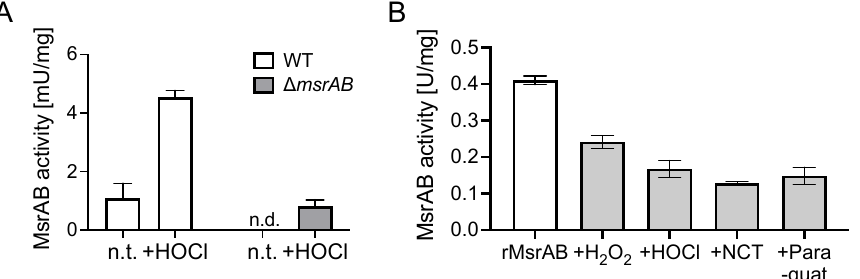
Figure 3. Effects of oxidative stress agents on rMsrAB activity. ( A ): MsrAB activity in Hi2019 wildtype and msrAB strains during microaerobic growth with or without exposure to hypochlorite. ( B ): Effect of exposure to ROS or RCS on activity of purified rMsrAB. n.t.—not treated; n.d.—not detected. NCT—N ‐ Chlorotaurine.